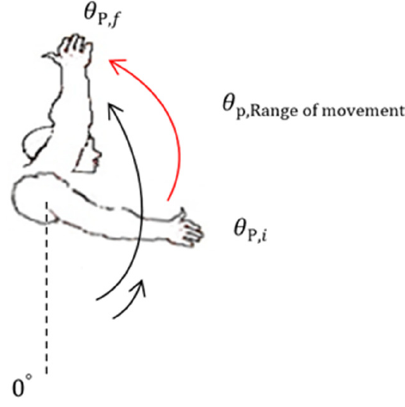
Figure 5. The range of movement of the shoulder joint.